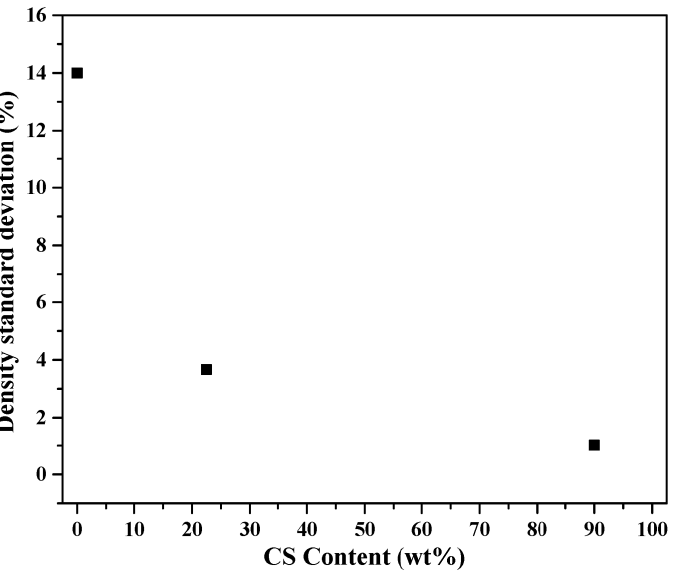
Figure 8. Density standard deviation of composite scaffolds with various CS content.